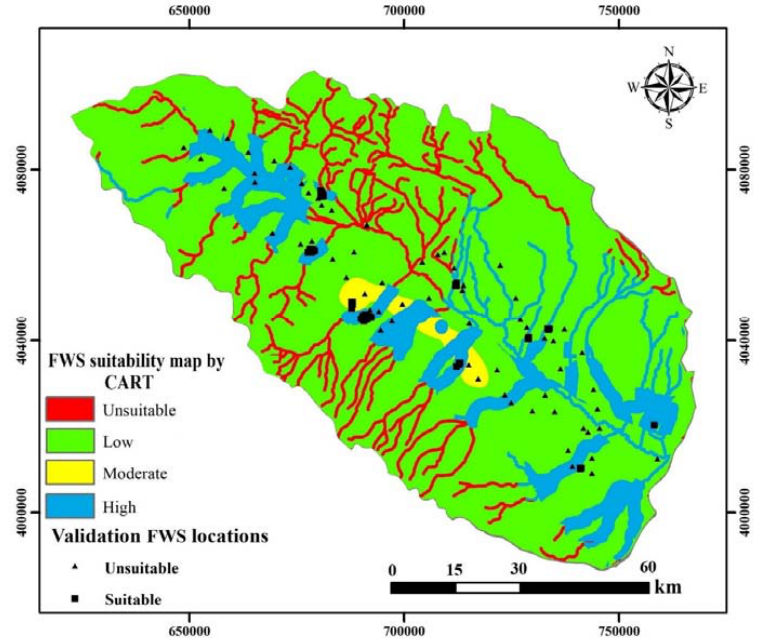
Figure 9. The FWS suitability maps produced by the CART algorithms.